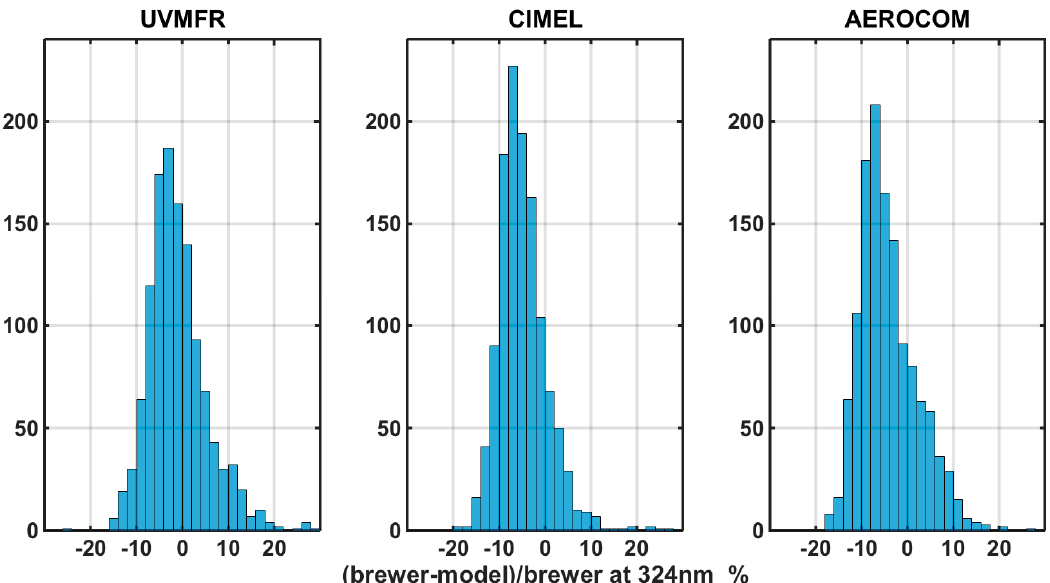
Figure 9. Number of cases of relative difference between Brewer recorded Irradiance at 324 nm and estimated through RTM calculations using SSA UVMFR at 332, SSA CIMEL at 440 nm, and SSA AEROCOM at 300 nm.